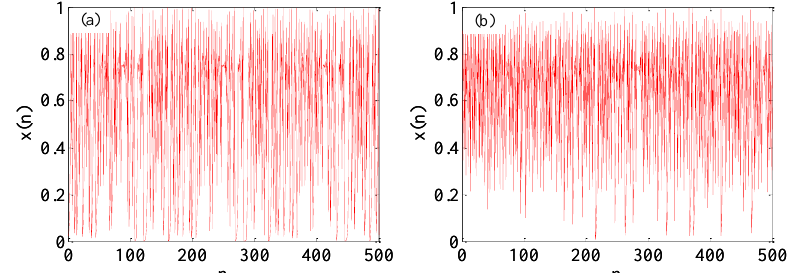
Figure 8. Iterative values produced by the logistic map and the proposed method based on digital implementation. ( a ) The original logistic map; ( b ) The enhanced logistic